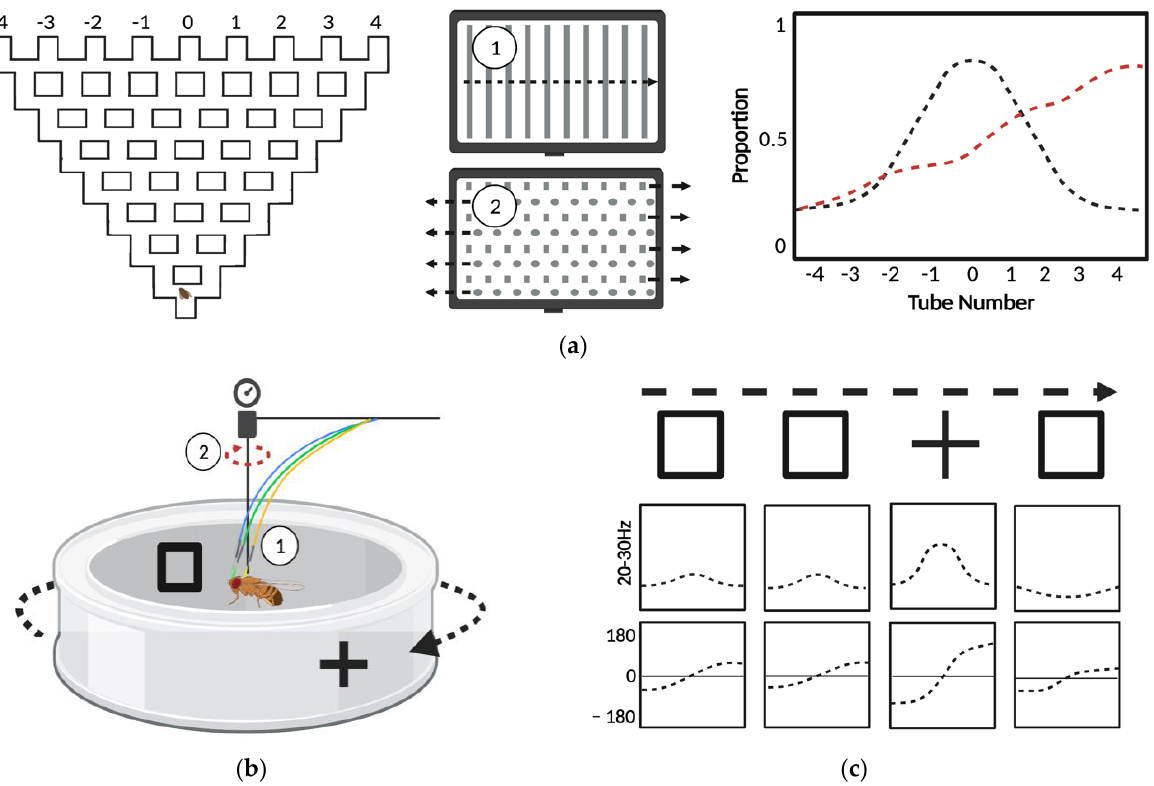
Figure 5. Assays for measuring attention-like processes in Drosophila ( a ) Depiction of a fly at the first of 8 successive choice points in a optomotor maze with nine possible outcomes. The bottom of the maze is clear, allowing presentation of visual stimuli by placement on top of monitor, here the maze is depicted in the absence of visual stimuli. The numbers across the top represent collection tube designations, and the values used for assigning tube score. A representation of two different patterns of moving visual stimuli (middle) that can be placed under the Y-maze to measure optomotor response (1) or optomotor distraction (2). Line graph depicting the proportion of flies in each collection tube (right) for an assay performed in the absence of visual stimuli (black dashed line) and an optomotor response assay involving presentation of a moving-grating pattern (red dashed line). ( b ) Ilustration of a tethered fly positioned in a visually programmable flightless arena where responses to visual stimuli are determined based on (1) electrophysiological recordings of brain activity and (2) measurement of physical response using a torque meter. ( c ) Depiction of visual-stimuli sequentially presented in a panorama during a closed-loop assay above representative responses to novel and non-novel visual stimuli that move across a tethered fly’s field of view, which is centered at the middle of each pane. The top row of boxes depicts 20 – 30 Hz Low Field Potential recordings of neural activity while the lower row represents the magnitude of torque responses. Created with BioRender.com.